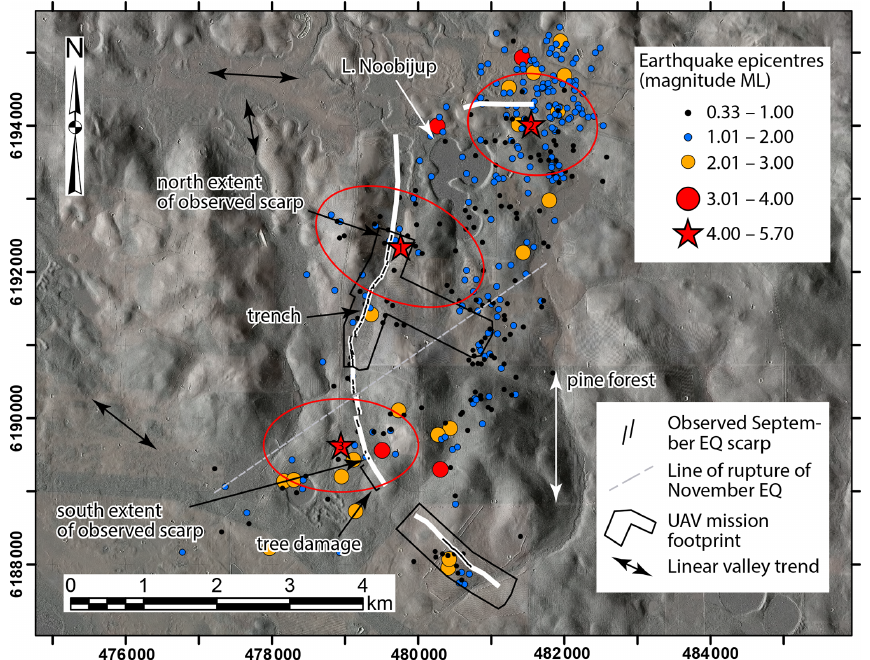
Figure 3. Map of the Lake Muir surface ruptures and associated seismicity. Background map is part of the Western Australian Department of Biodiversity, Conservation and Attractions lidar holdings (https://www.dbca.wa.gov.au/contact-us, last access: 27 September 2018) with Esri world imagery overlain at 75% transparency. White line shows the extent of the discrete surface rupture relating to the September event, as mapped from InSAR. Superposed black lines are scarp segments mapped on the ground. Grey dashed line shows the discrete line of deformation relating to the November event, as mapped from InSAR. The three largest events and their uncertainty ellipses, 16 September M w 5.3, 12 October M l 4.6 and 8 November M w 5.2, are consecutively numbered (see Table